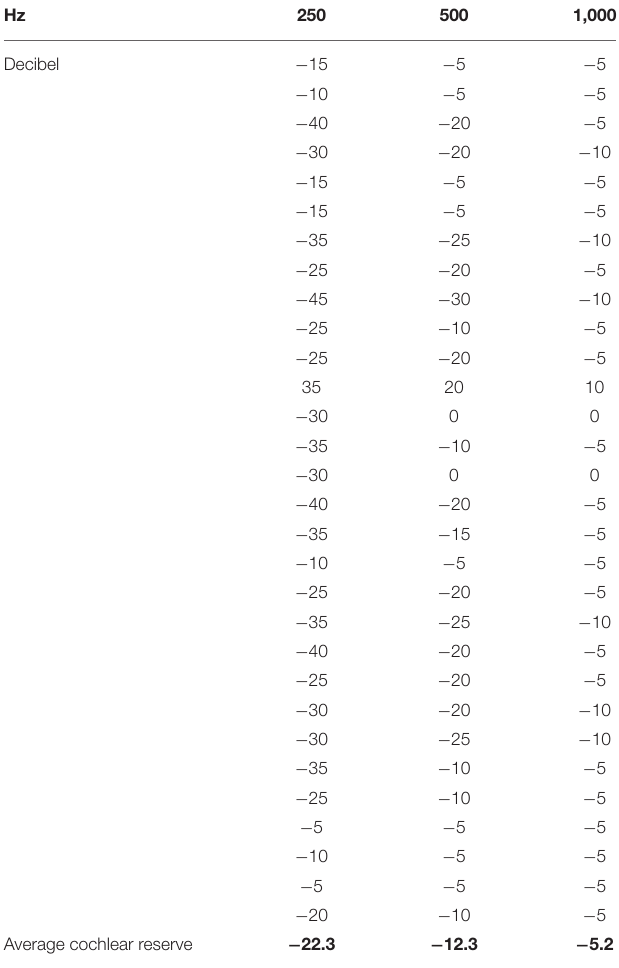
TABLE 3 | Ratio between positive and negative patients on MRI and patients with cochlear reserve > 10 dB on the frequencies 250-500-1000Hz ( p = 0.002) sensibility 86%.